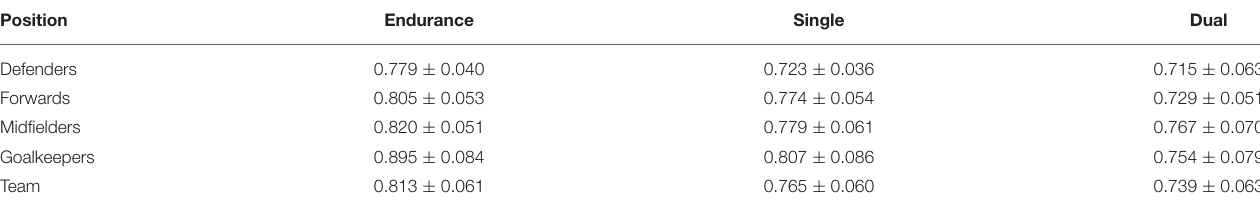
TABLE 1 | Total average reaction time during proactive tasks. Position